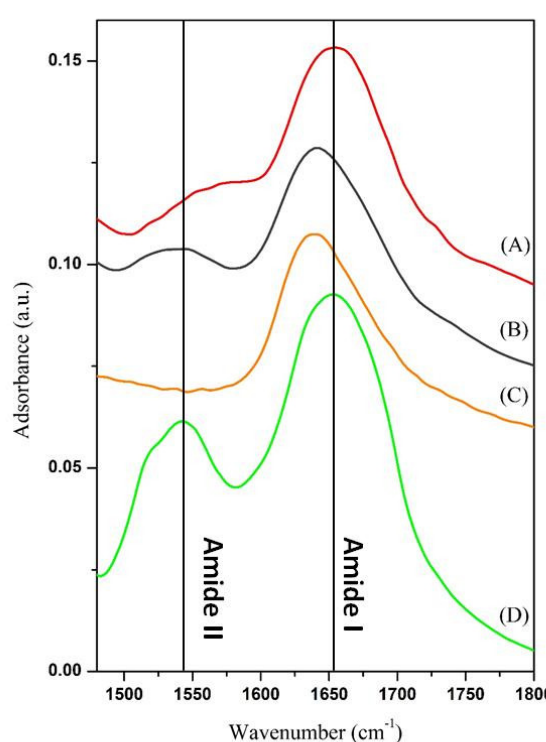
Figure 4. FT-IR spectra of cellulase adsorbed on WSN-p (A), WSN-calc (B) and WSN-ipa (C) and free cellulase (D).